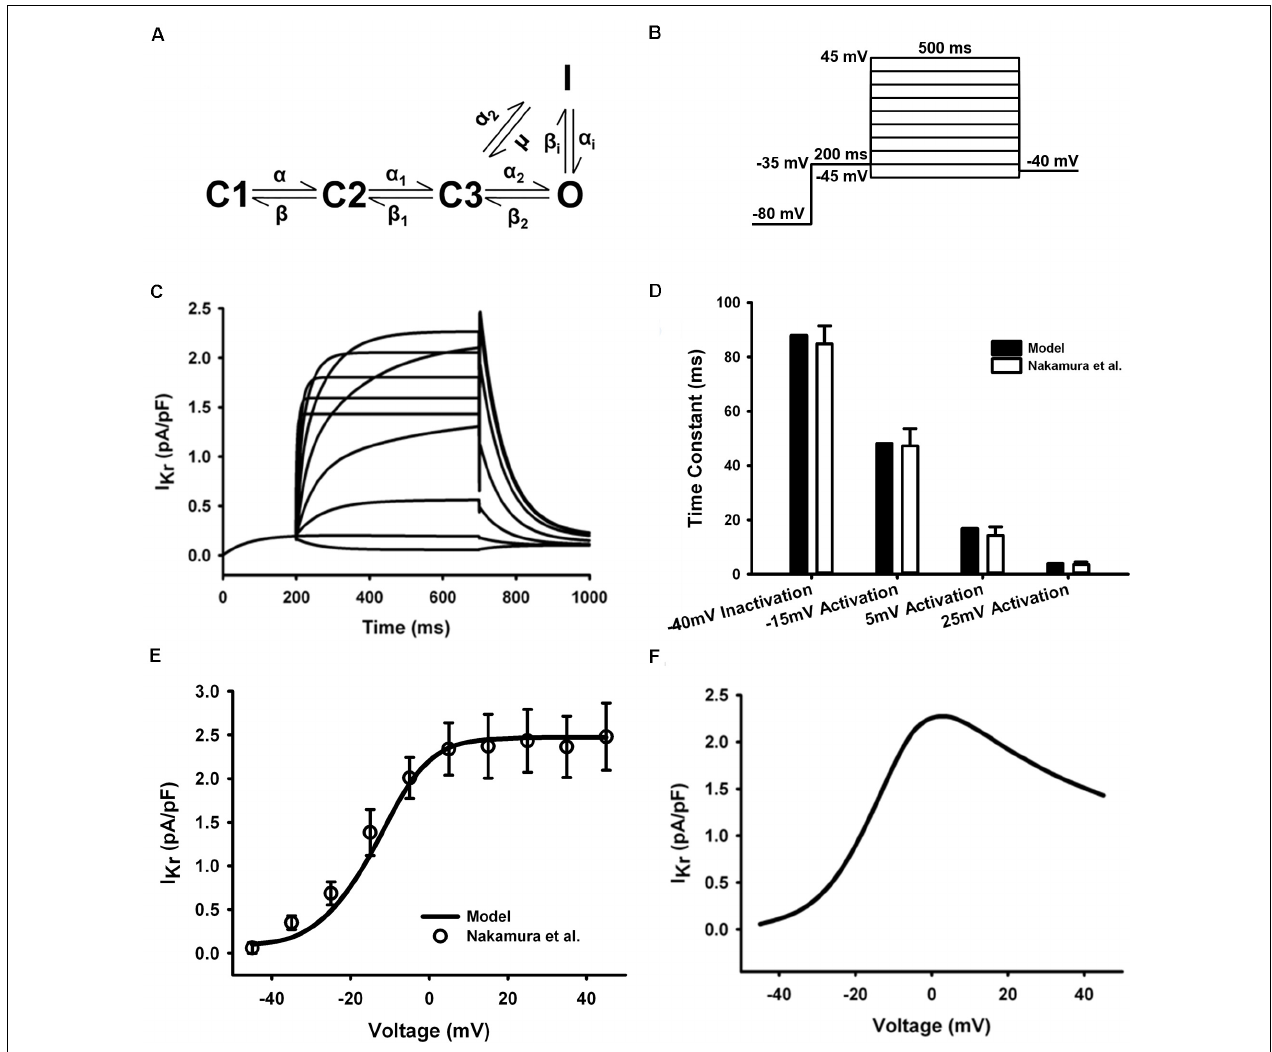
FIGURE 5 | I Kr in the atrial myocyte model and comparison with experimental data. (A) Five-state Markov chain model of I Kr . (B) The protocol used in the simulation. (C) Current traces for the corresponding voltage clamp protocol. (D) Time constants for inactivation and activation. (E) Tail I–V relationship. (F) Steady-state I–V relationship (Experimental data: Nakamura et al.,